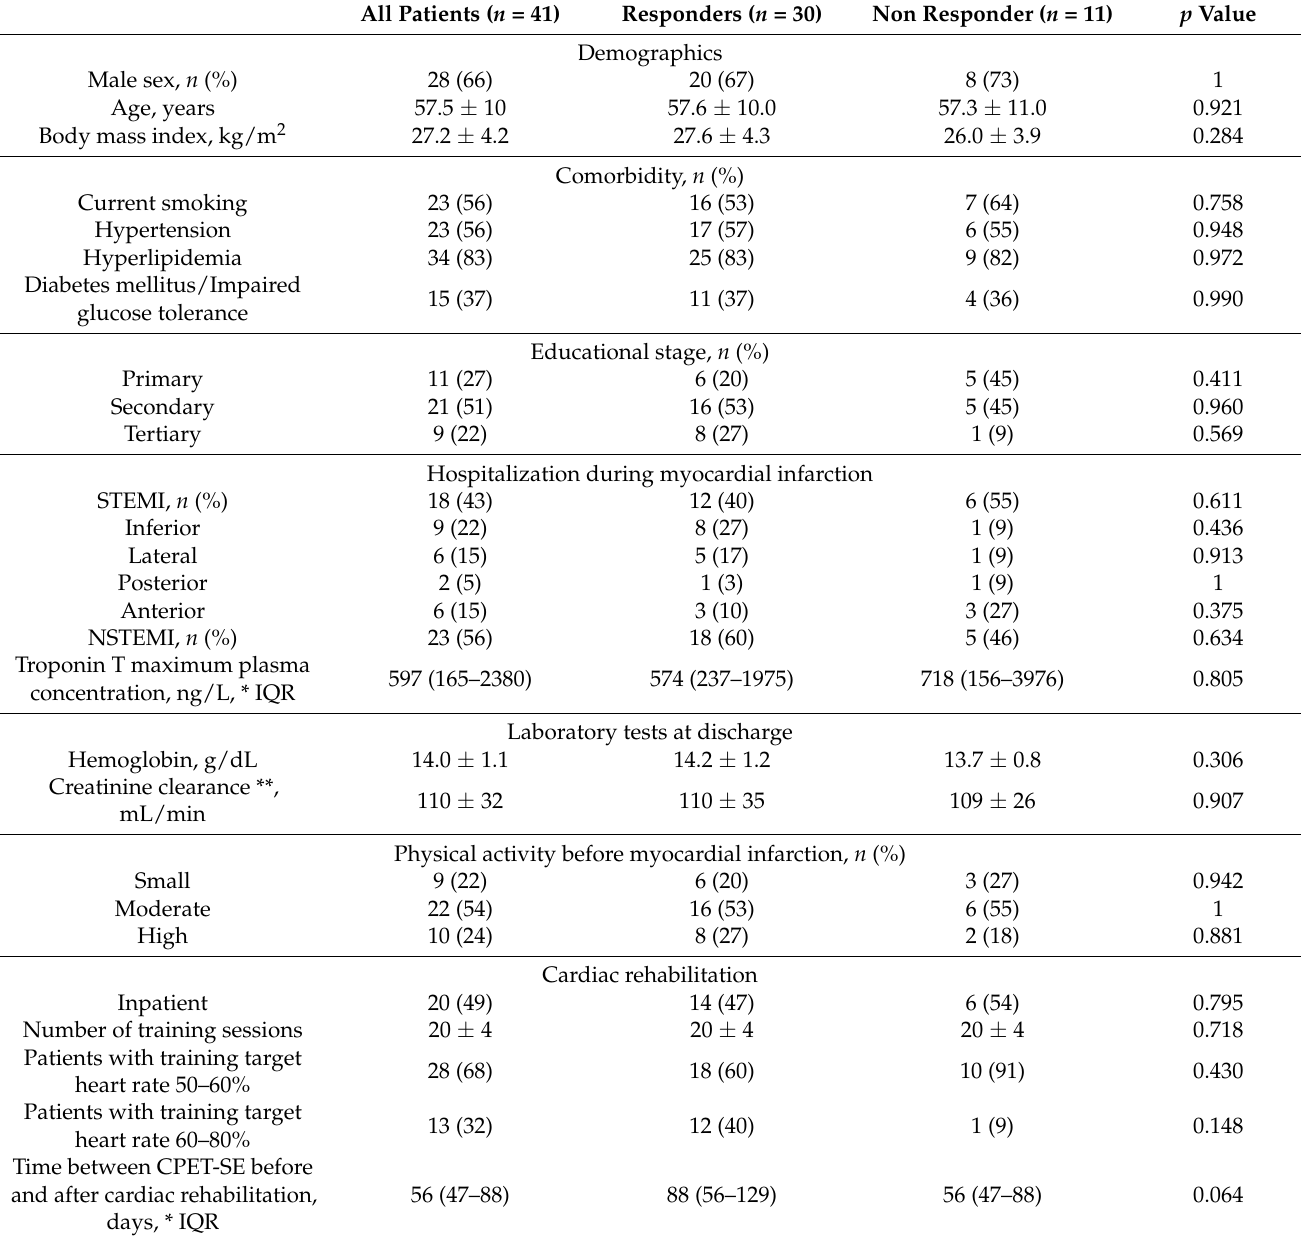
Table 1. Clinical characteristics of studied